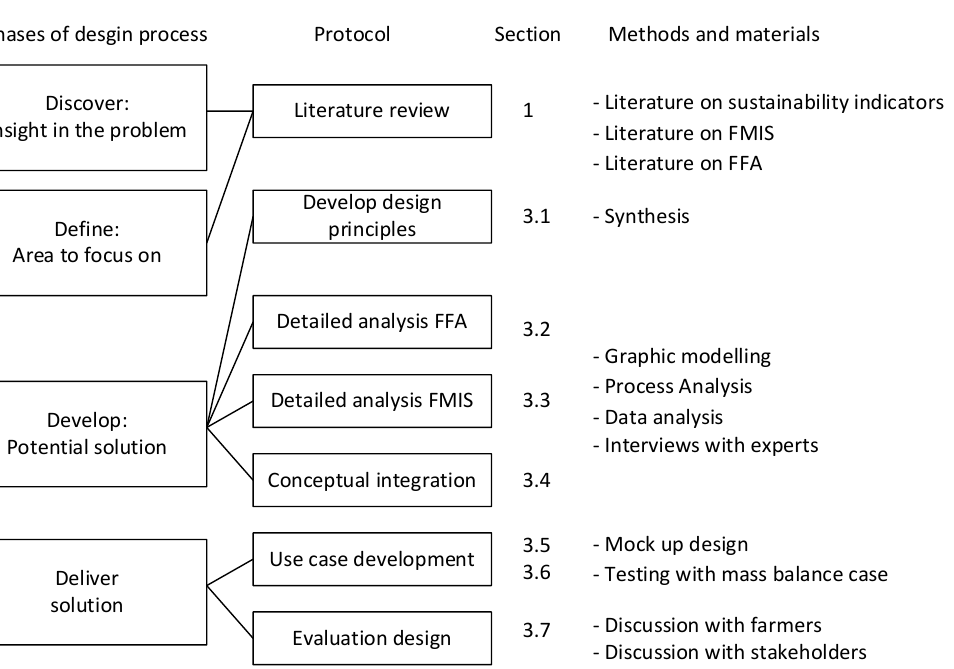
Figure 1. Outline of the study: design phases, protocol, and detailed methods and materials.